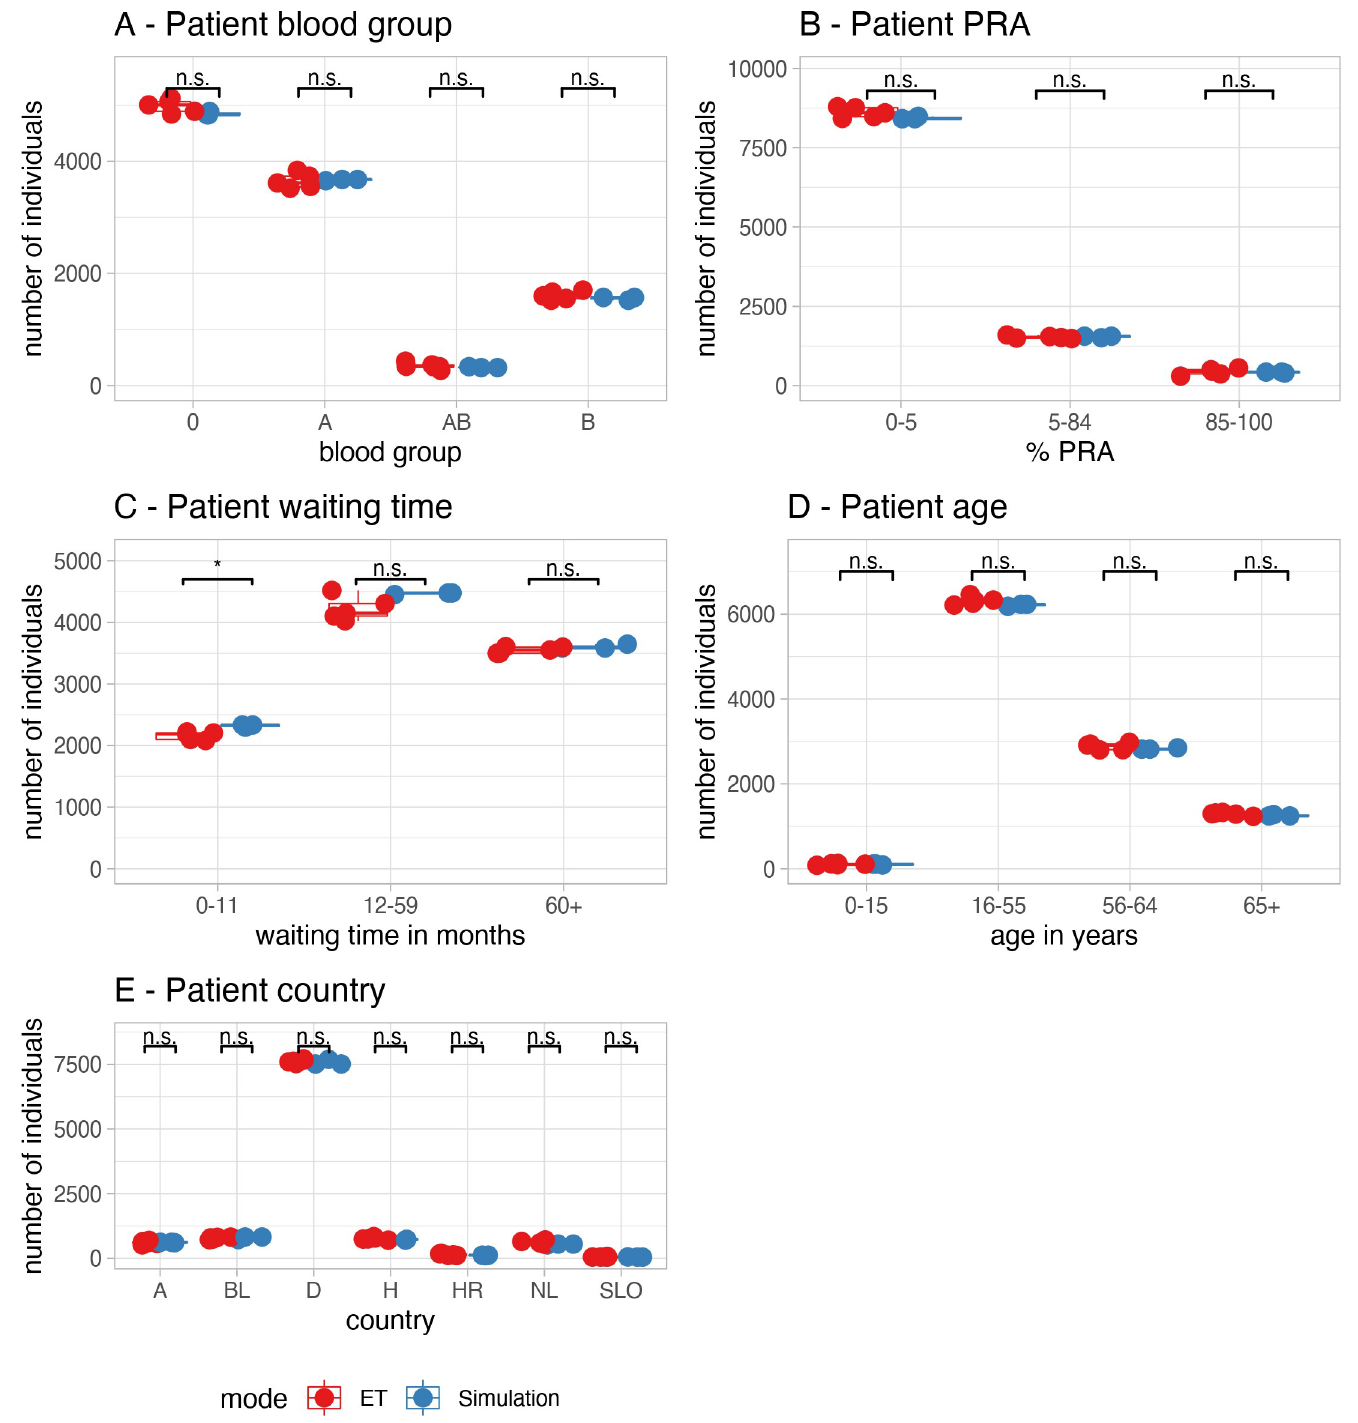
Fig 4. Bootstrap validation. Comparison of the bootstrapping results (blue dots) versus the data reported by ET in the years 2013–1017 (red dots). Waiting time was calculated from the start of dialysis. Significant differences (p < 0.01) are indicated with a " � ".